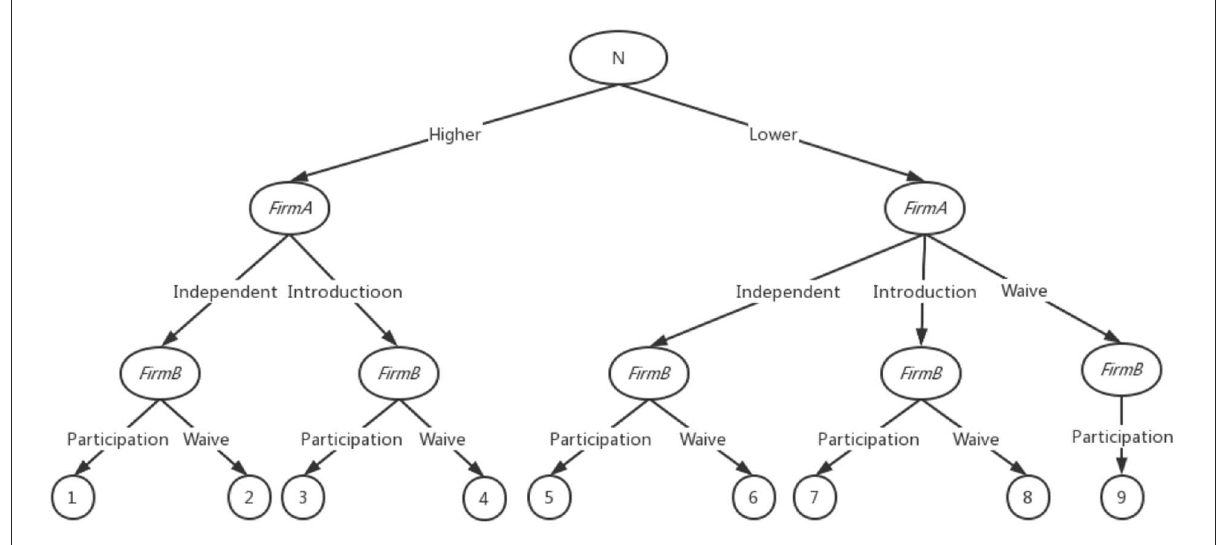
FIGURE1 An extended representation of a firm’s innovation